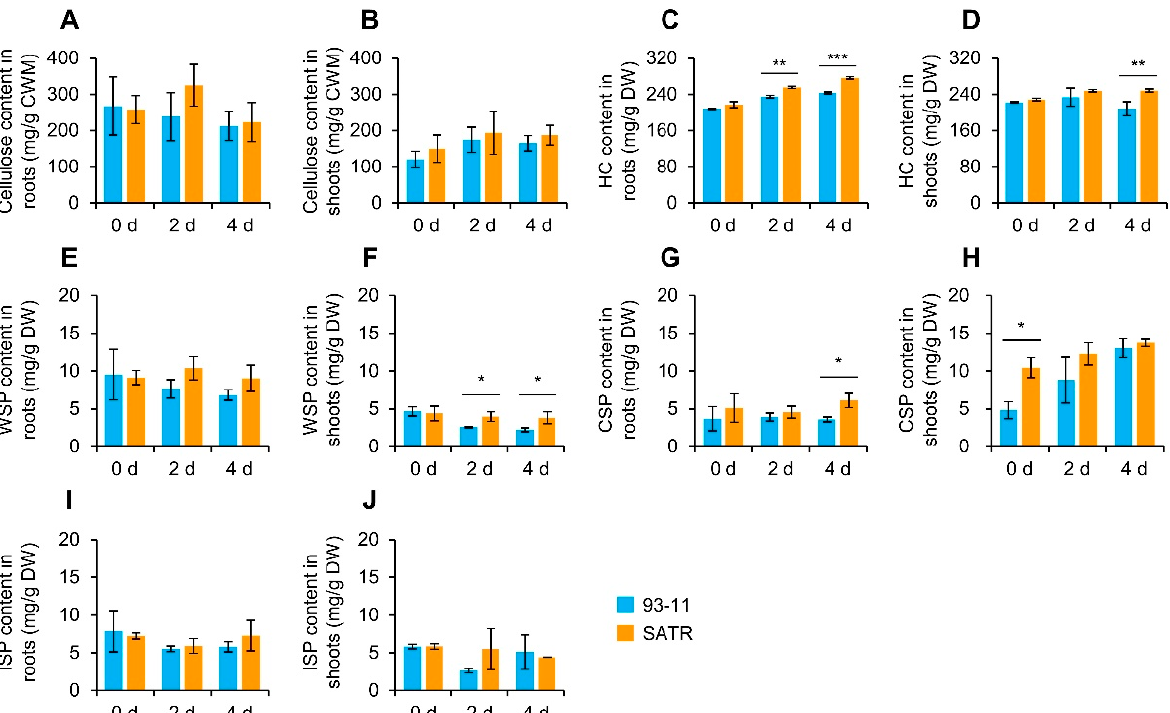
Figure 6. Comparisons of cellulose, hemicellulose and pectin contents between SATR and 93-11 under SSAS. Contents of cellulose in roots ( A ) and shoots ( B ), hemicellulose (HC) in roots ( C ) and shoots ( D ), water-soluble pectin (WSP) in roots ( E ) and shoots ( F ), covalently soluble pectin (CSP) in roots ( G ) and shoots ( H ), and ionic-soluble pectin (ISP) in roots ( I ) and shoots ( J ) in STAR and 93-11 seedlings under SSAS for 0 days, 2 days, and 4 days, respectively. Data is given as mean ± SD, which was obtained from three independent biological replicates, and each sample contained 13 mixed seedlings. Student’s t -test, * p < 0.05, ** p < 0.01, *** p < 0.001.